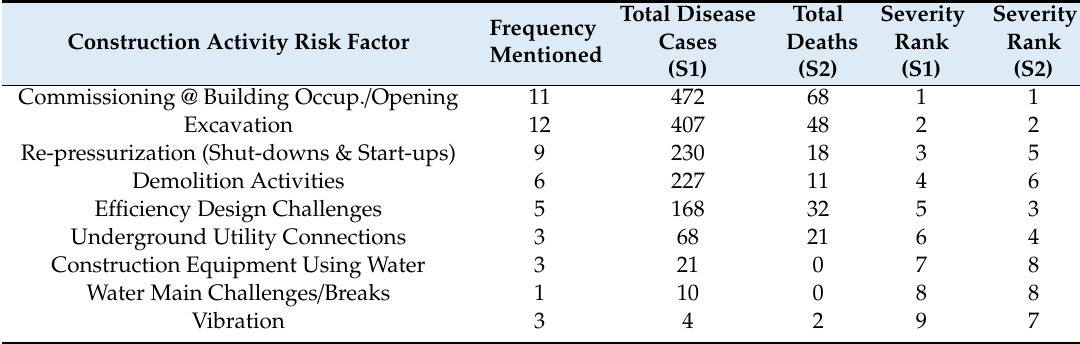
Table 5. Construction activity risk factors & severity